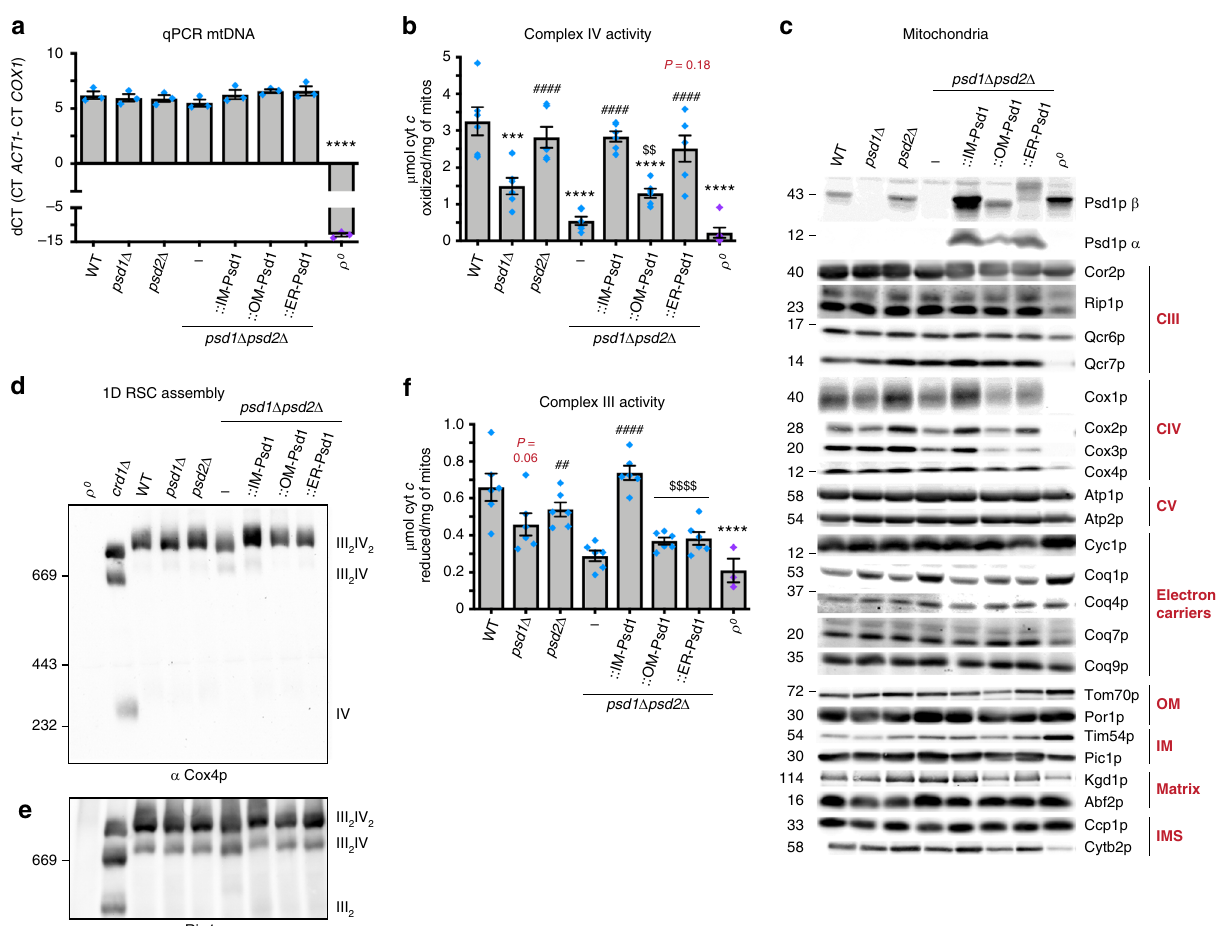
Fig. 5 Complex III and IV activities are impaired when Psd1 is absent in the IM. a mtDNA was isolated from the indicated strains, normalized, and quanti fi ed by qPCR (mean ± S.E.M. for n = 3 biologically independent experiments). Analysis was performed by one-way ANOVA with Tukey ’ s multiple comparison test. b Complex IV activity in isolated mitochondria solubilized in 0.5% (w/v) DDM (mean ± S.E.M. for n = 6 biologically independent experiments, except for ρ 0 , n = 3). c Mitochondria from the indicated strains were immunoblotted for subunits of complex III (CIII), complex IV (CIV), complex V (CV), the Coq synthome, cytochrome c , and markers of each mitochondrial compartment. d , e Blue native-PAGE analysis of respiratory supercomplexes (RSCs) using mitochondrial extracts solubilized in 1.5% (w/v) digitonin. d Complex IV assembly was monitored by immunoblot against the nuclear-encoded subunit Cox4 and ( e ) Complex III assembly was monitored by immunoblot against the nuclear-encoded subunit Rip1. Mitochondria lacking CL ( crd1 Δ ) were used as a positive control for RSC destabilization 53 . f Complex III activity in isolated mitochondria solubilized in 0.5% (w/v) DDM (mean ± S.E.M. for n = 6 biologically independent experiments, except for ρ 0 , n = 3). In B and F, statistical comparisons (ns, P > 0.05; 1 symbol P ≤ 0.05; 2 symbols P ≤ 0.01; 3 symbols P ≤ 0.001; 4 symbols P ≤ 0.0001) versus WT (asterisk), psd1 Δ psd2 Δ (number sign), or IM-Psd1 (dollar sign) were performed by one-way ANOVA with Tukey ’ s multiple comparison test. P values for decreases that didn ’ t achieve signi fi cance are reported in red and were analyzed by student